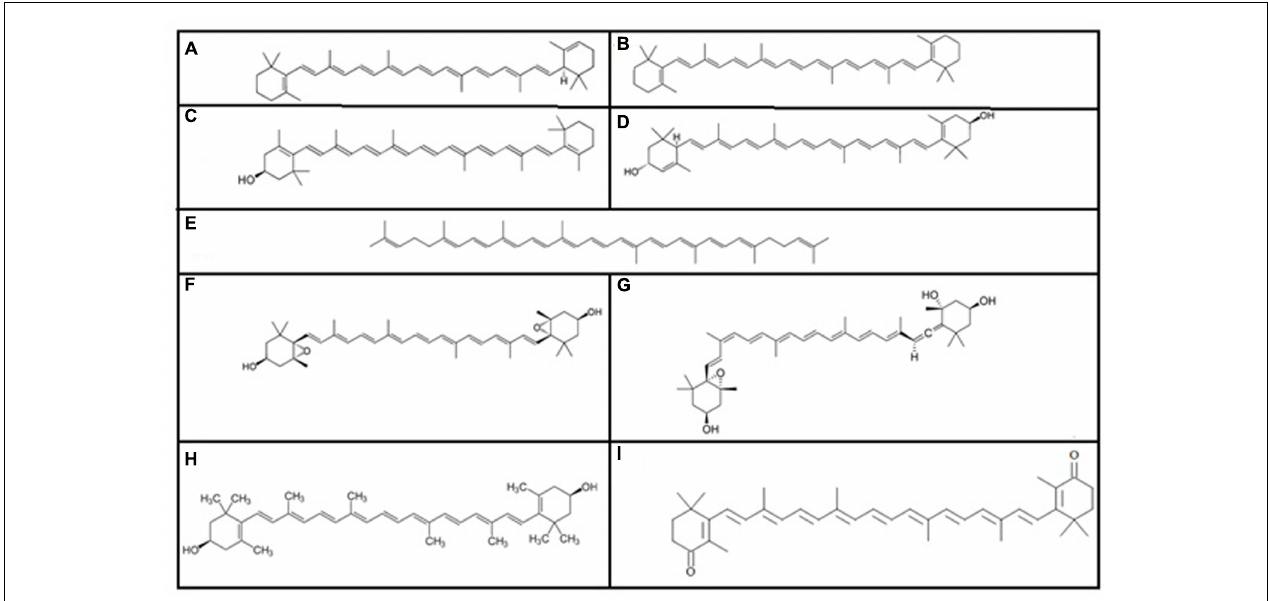
FIGURE 1 | Some important carotenoids: (A) alpha carotene, (B) beta-carotene, (C) cryptoxanthin, (D) lutein, (E) lycopene, (F) violaxanthin, (G) neoxanthin, (H) zeaxanthin, and (I) canthxanthin.